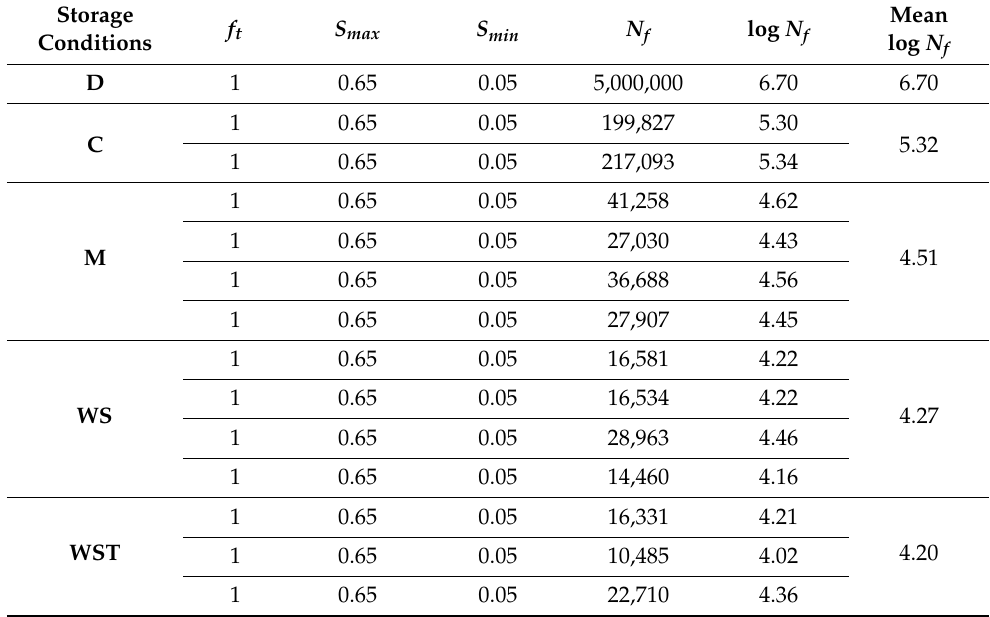
Table A2. The numbers of cycles to failure depending on the storage conditions for RH1